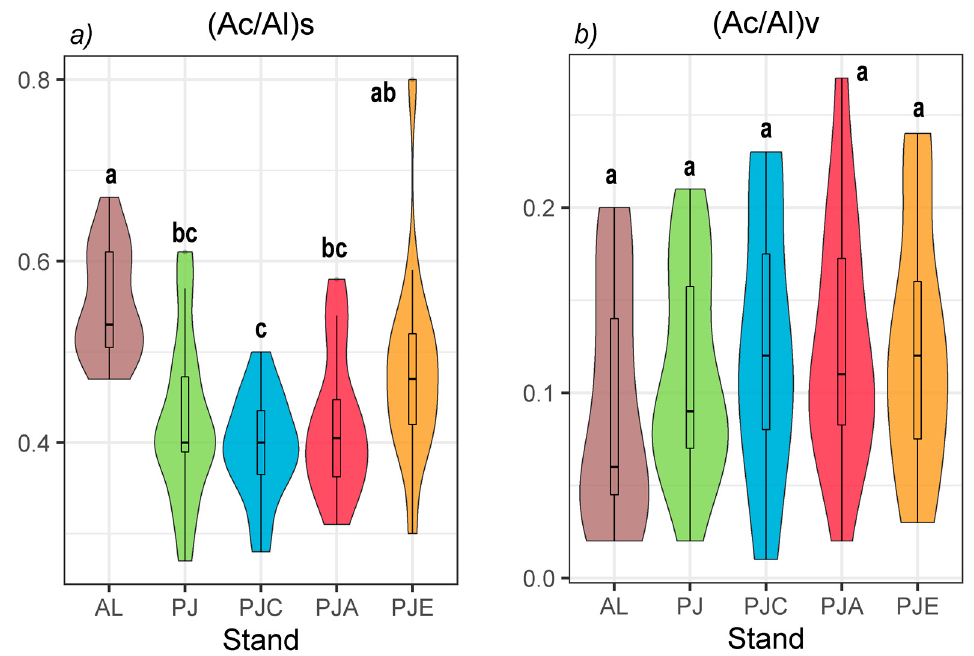
Figure 2. The lignin-derived phenolic acid to their corresponding aldehydes ratios of (Ac/Al) for ( a ) syringyl units (Ac/Al)s and ( b ) for vanillyl units (Ac/Al)v in the afforested stands and agricultural land stands. Data are represented as violin plots with a nested boxplot. Violin plots that do not share at least one letter are significantly different ( p ≤ 0.05 , Tukey’s post-hoc test follows one-way ANOVA).